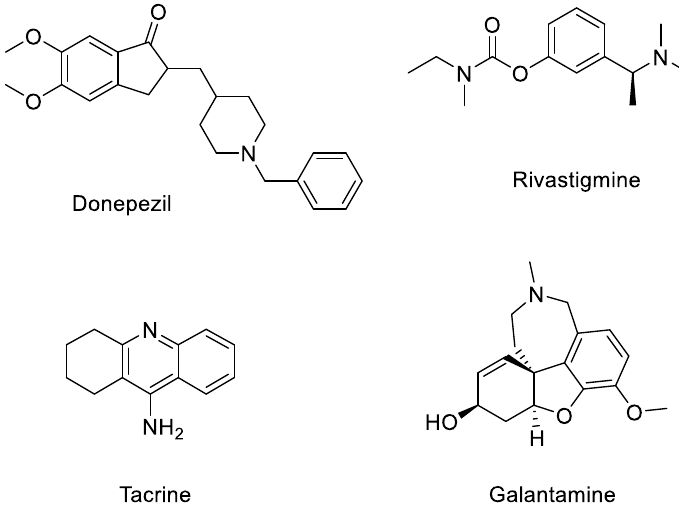
Figure 1. Structures of approved AChE inhibitors.